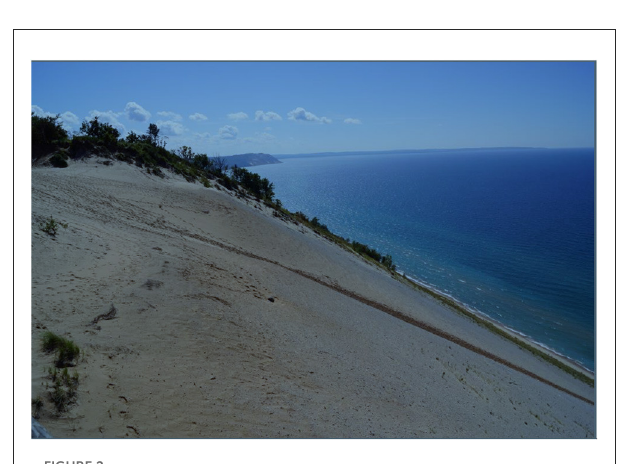
FIGURE2 Sleeping bear dunes and lake